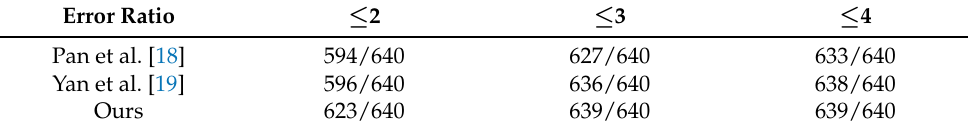
Table 2. Quality evaluation of competitive methods on dataset [22] in terms of error ratio.